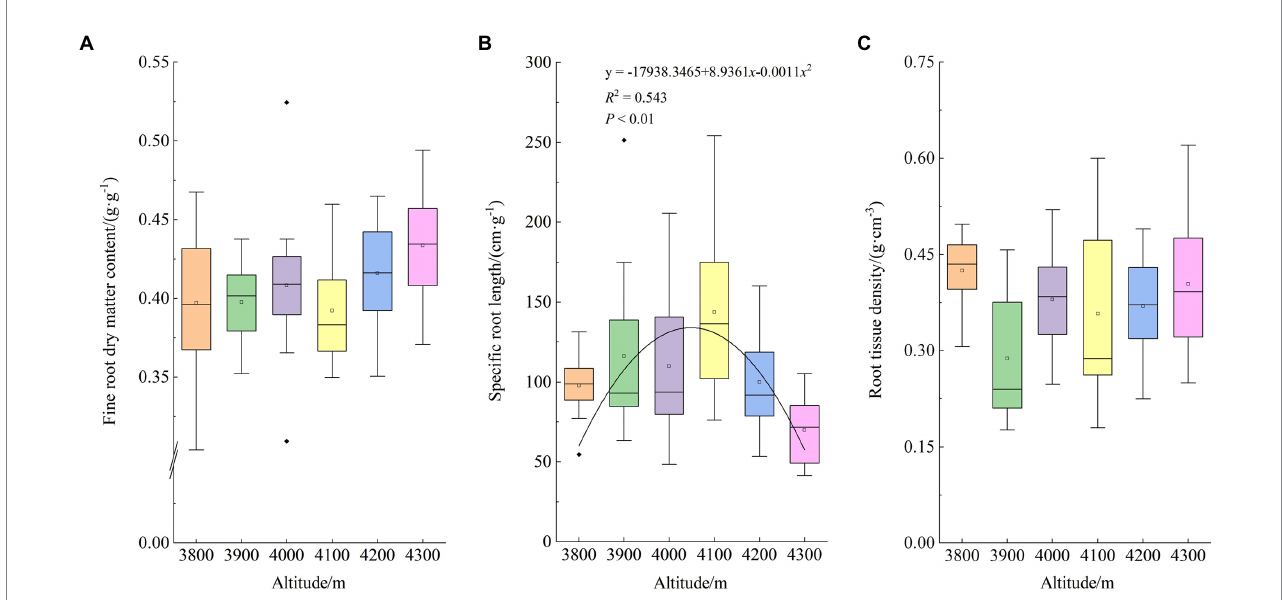
FIGURE 5 Altitudinal distribution of functional traits of fine roots of Abies georgei var. smithii. in southeast Tibet. (A) Root dry matter content (RDMC); (B) Specific root length (SRL); (C) Root tissue density